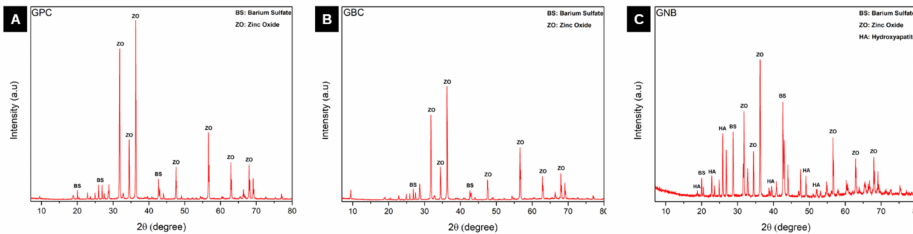
Figure 6. Representative spectrum of the XRD analysis of samples from all evaluated groups. ( A ) GPC group after 28 days of immersion in SBF. Presence of patterns corresponding to barium sulfate and zinc oxide; ( B ) GBC group after 28 days of immersion in SBF. Similar to the GPC group with the presence of patterns corresponding to barium sulfate and zinc oxide. ( C ) GNB group after 28 days of immersion in SBF. In addition to the presence of patterns corresponding to barium sulfate and zinc oxide, there was the presence of hydroxyapatite, attributed to the formation of precipitates identified in